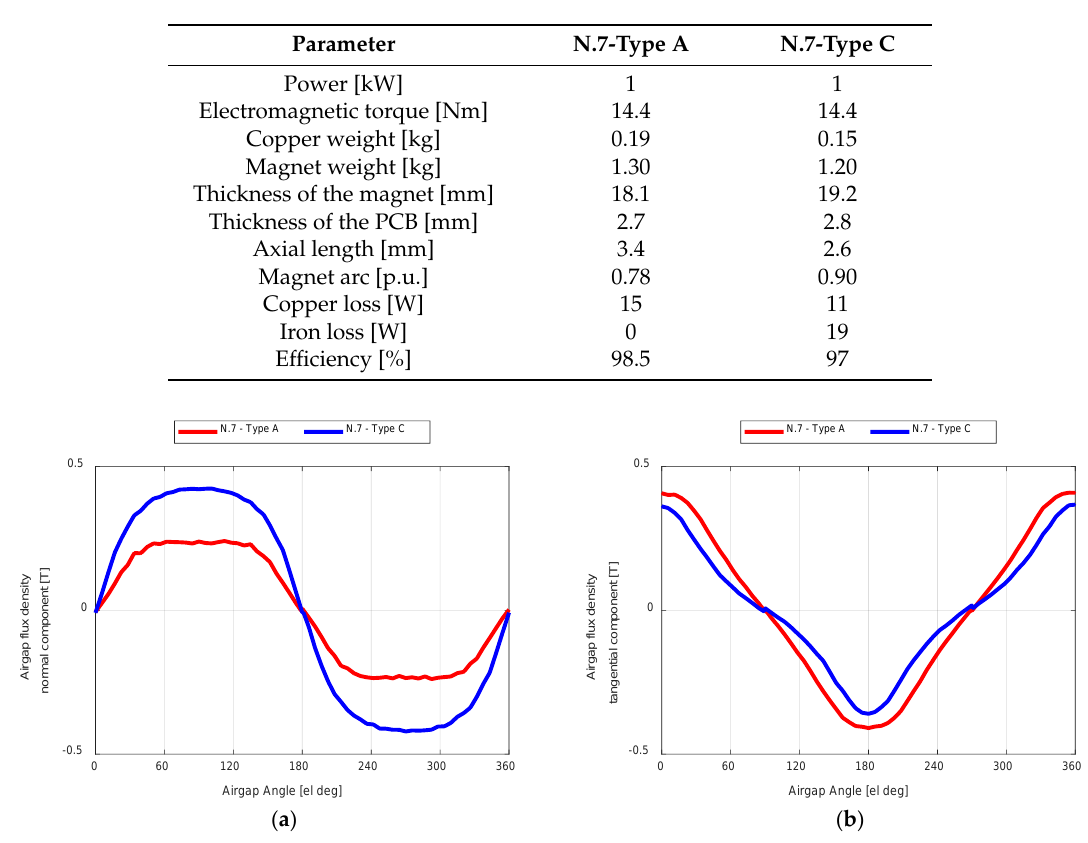
Table 2. Characteristics of the two selected machines.